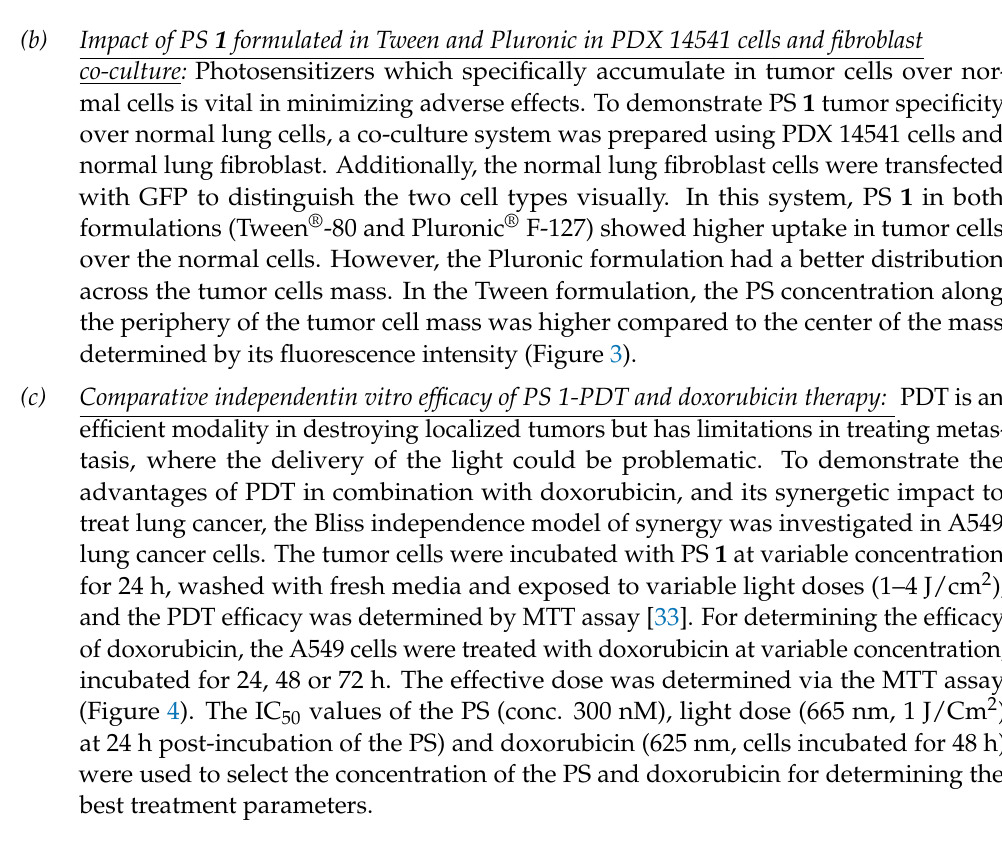
Figure 2. A comparative in vitro PDT efficacy of PS 1 formulated either in 1% Tween ® -80 (left graph) or 2% Pluronic ® F-127 (right graph) in lung cancer cell line 14541 derived from a lung cancer patient. The cells were incubated with PS 1 for 24 h, and then exposed to light (665 nm, 1–4 J/cm 2 ) 24 h. The PDT efficacy was determined by MTT assay, and the results were analyzed using GraphPad Prism 7